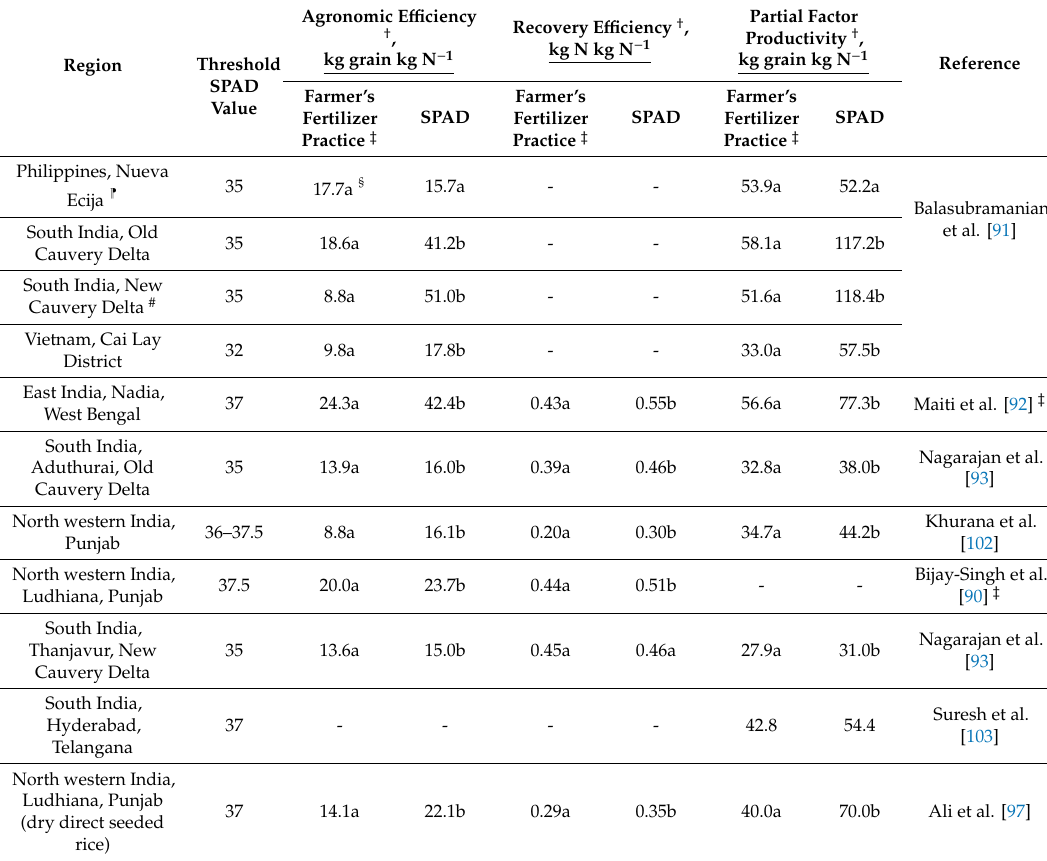
Table 2. Effect of soil plant analysis development (SPAD) chlorophyll meter-based fertilizer N management on fertilizer N use efficiency in rice in Asia.